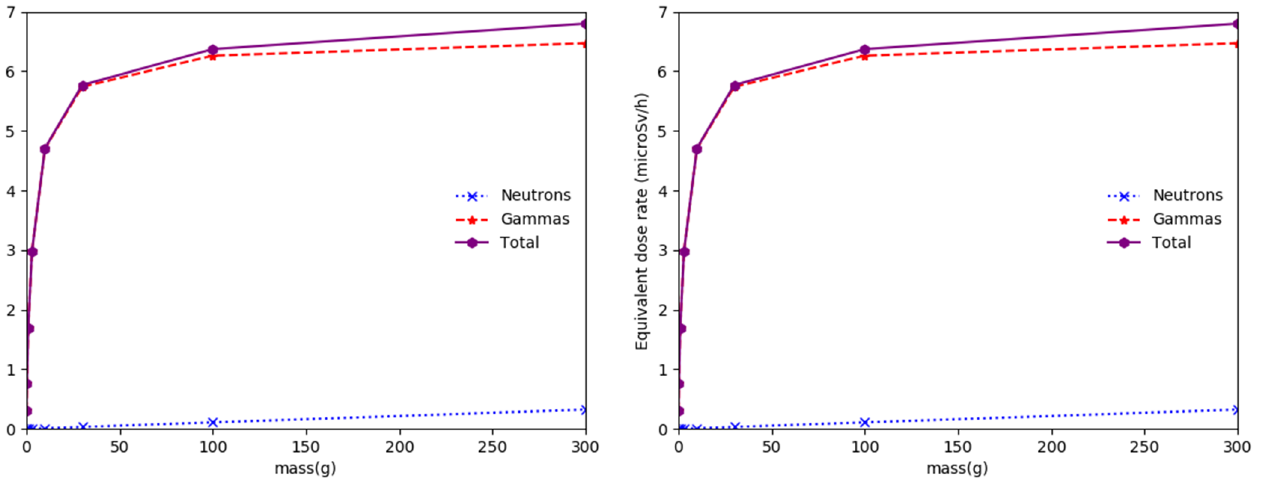
Fig. 5. Homogeneous model, Corner source with parametrical variation of the density, results at 15cm from the source.